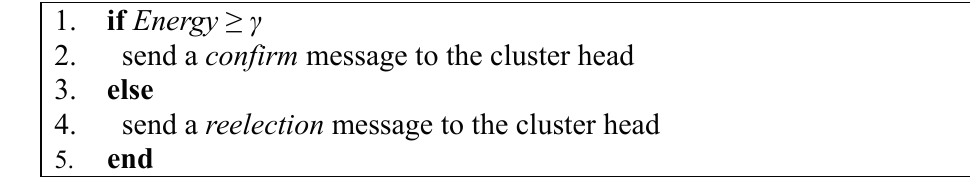
Figure 5. Procedure performed by the